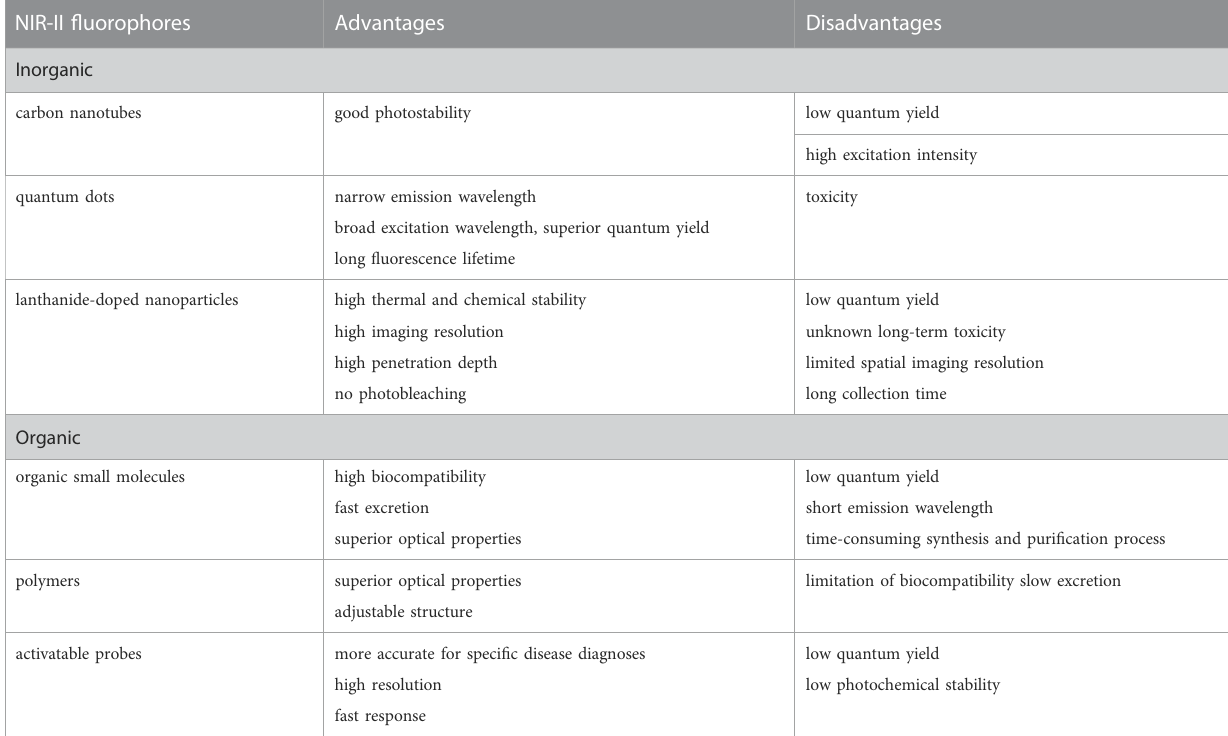
TABLE 1 The summary of advantages and disadvantages of NIR-II fl uorophores. NIR-II fl